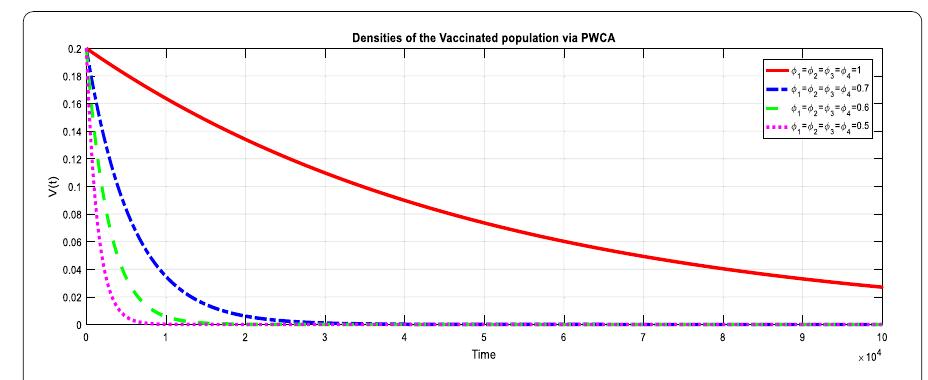
Figure 16 Dynamic of V ( t ) by varying the value of φ